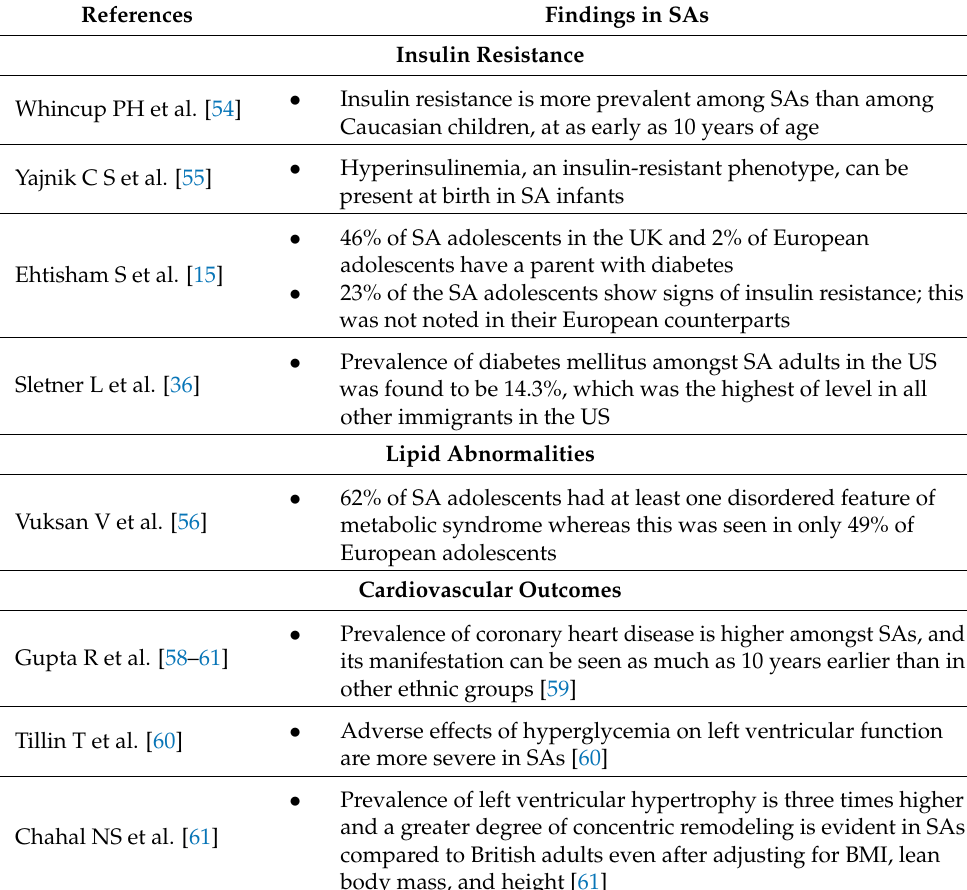
Table 3. Risks of metabolic syndrome in children of SA